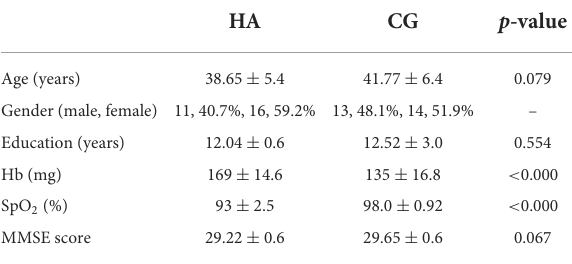
TABLE 1 Demographic, clinical data of the HA and